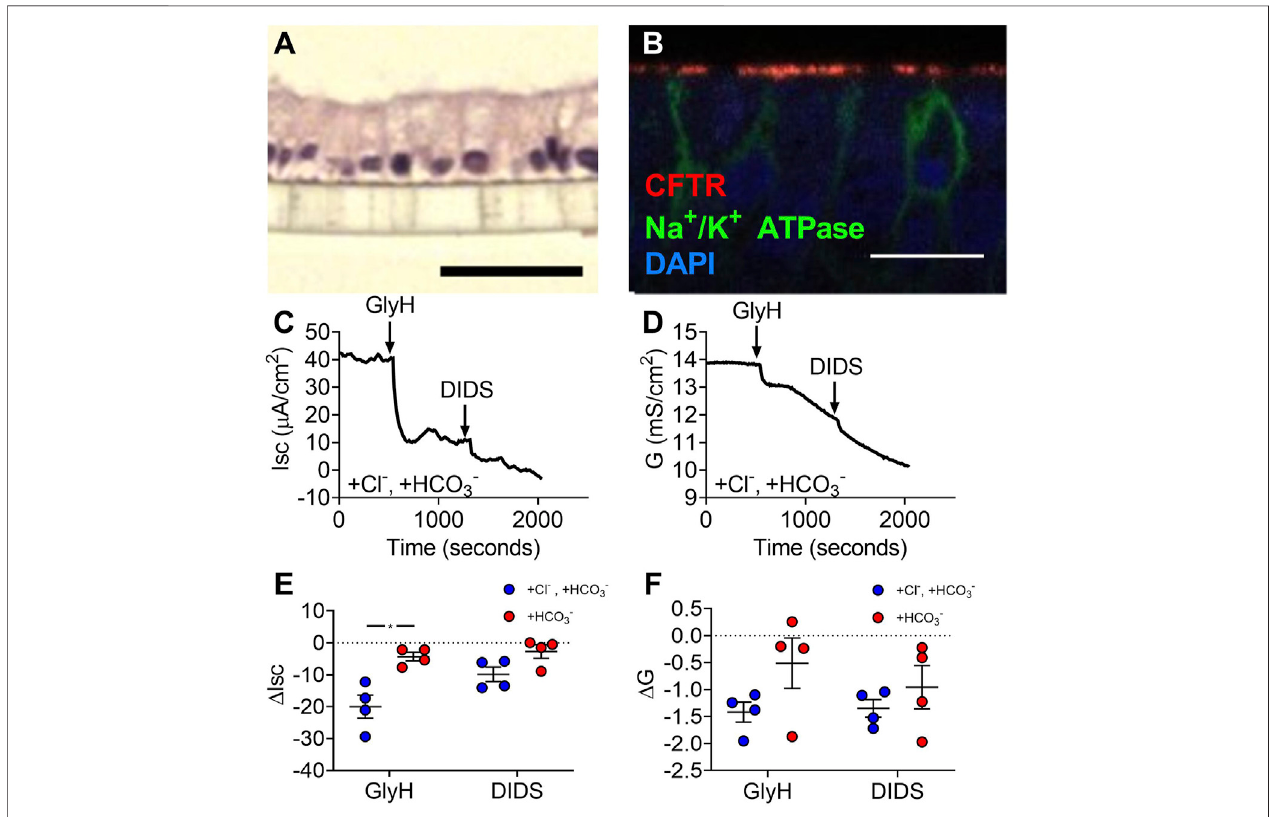
FIGURE2| Gallbladderorganoid-derivedmonolayershaveunstimulatedCl − -transportatbaseline. (A) H&E(scalebar=40 µm)and (B) immuno fl uorescence(scale bar = 100 µm) of human gallbladder epithelial organoid-derived monolayer cultures. Representative (C) short-circuit current and (D) conductance traces and (E) Δ Isc and (F) Δ G in Krebs ’ /HCO 3 − solution and Cl − -free solution. Bars indicate mean ± SEM. * indicates p -value < 0.05; multiple t-tests with Holm-Sidak correction for multiple comparisons.